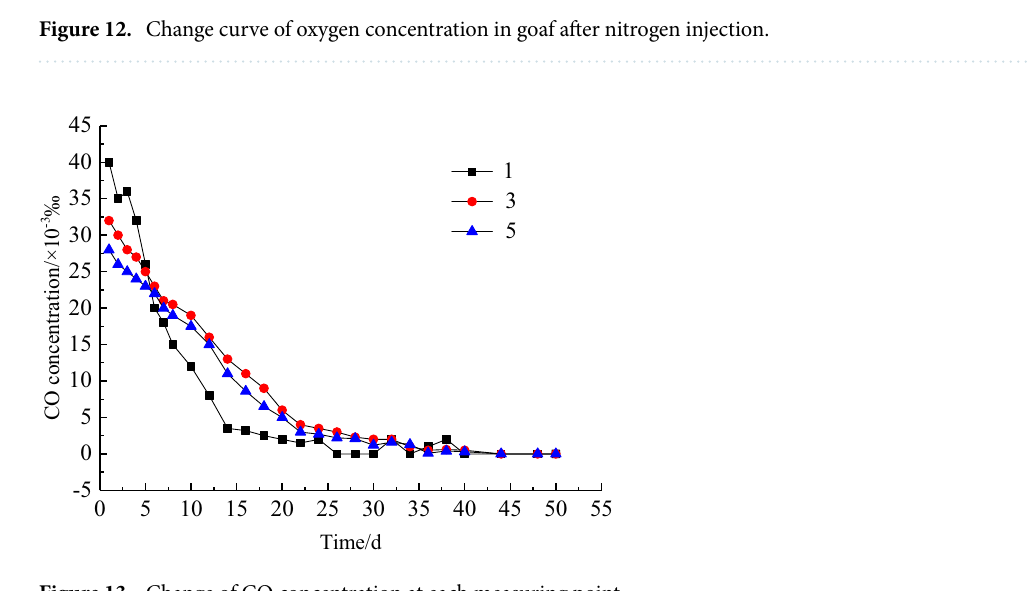
Figure 13. Change of CO concentration at each measuring point.